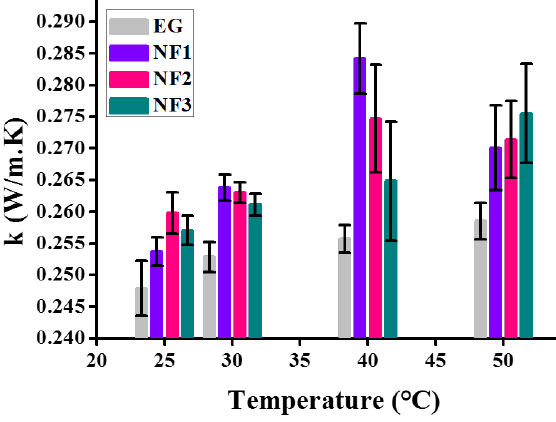
Figure 16. Variation of thermal conductivity over various temperatures. Table 6. Percentage (%) enhancement in thermal conductivity as compared to